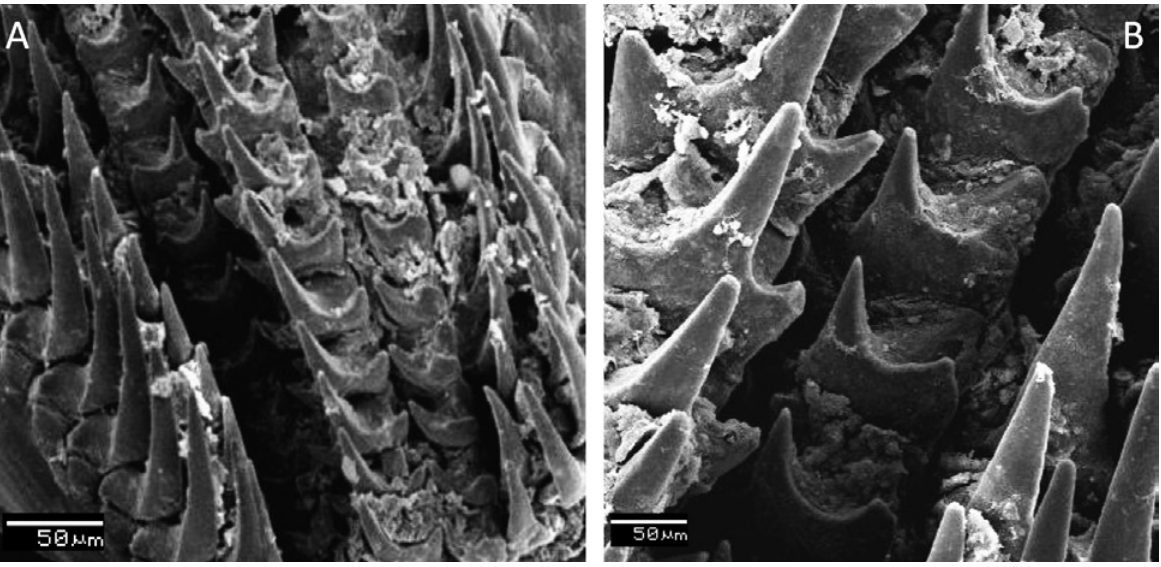
Figure 3 - Radula of Lolliguncula brevis of the Brazilian coast, viewed under scanning electron microscopy. A. Rachidian (central) and lateral teeth. B. Detail of the previous